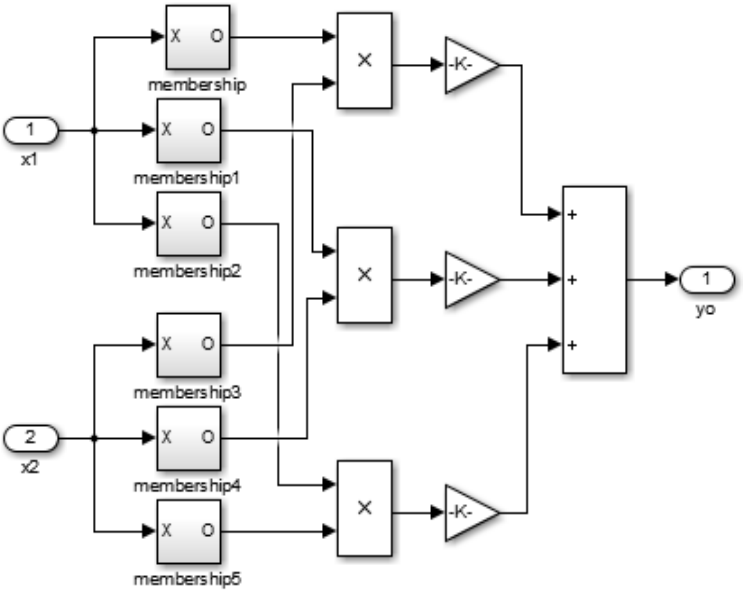
Figure 7. Simulink model of the FNN controller.